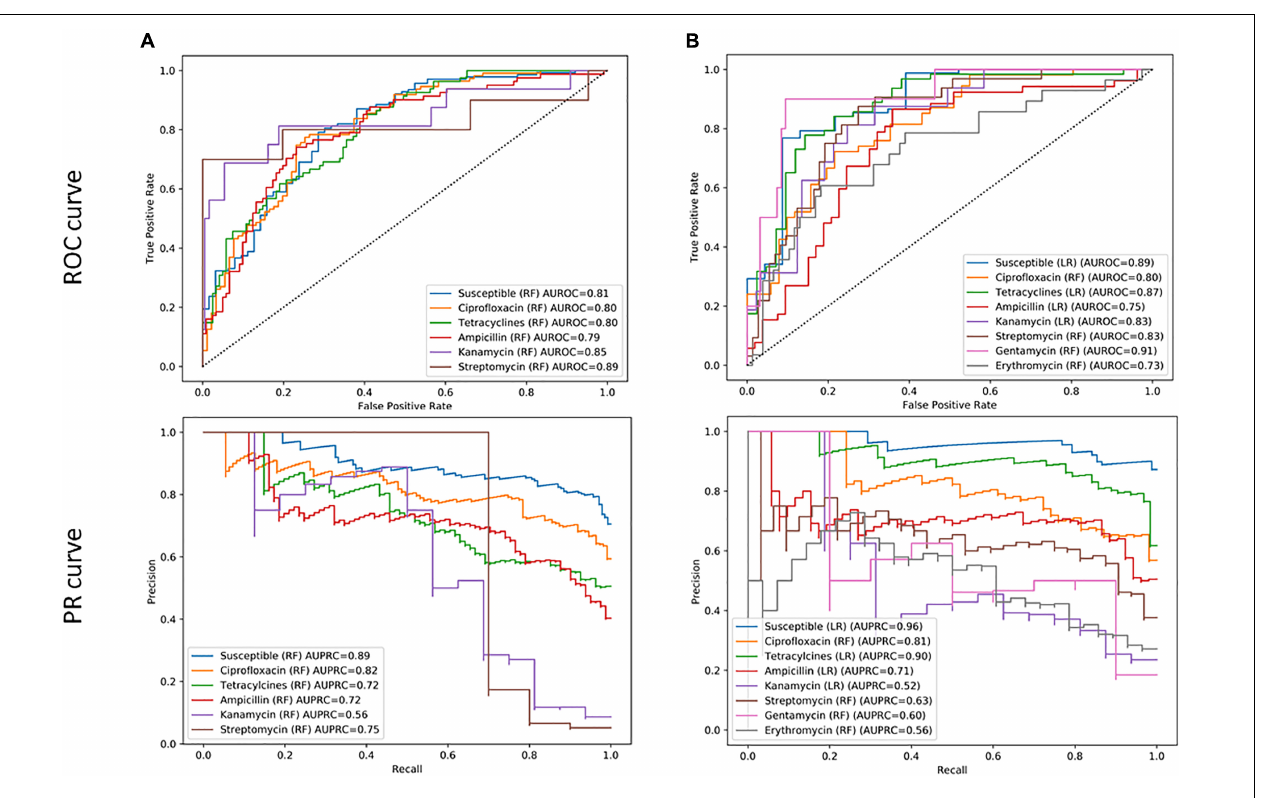
FIGURE 4 | Receiver operating characteristic (ROC) curve and recall–precision (PR) curves, and their related area under the curve, of specific antimicrobials based on 202 C. jejuni (A) and 105 C. coli (B) MALDI-TOF main protein spectra profiles (MSPs) of the test set (30%). RF, Random Forest algorithm; LR, Logistic regression algorithm; AUROC, Area under the ROC curve; AUPRC, Area under the precision–recall